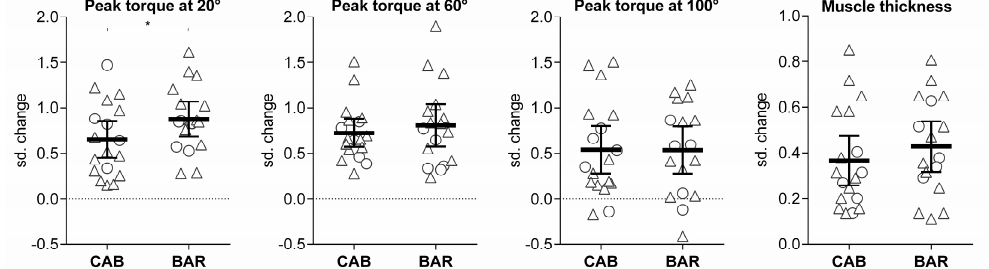
Figure 2. Individual standardized (sd.) changes (post-training minus pretraining value, divided by pooled pretraining standard deviation) for elbow flexion isokinetic peak torque at 20°, 60°, and 100°, and muscle thickness according to groups that performed cable (CAB, n = 18) or barbell (BAR, n = 17) preacher curl exercises. The horizontal lines represent mean and 95% confidence intervals. Triangles represent men, and circles represent women. * P < 0.05 between groups.